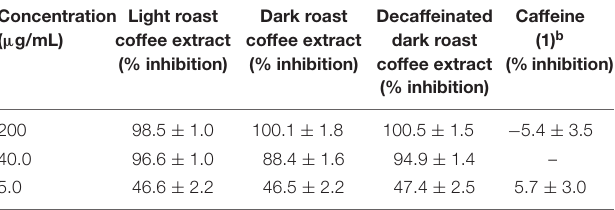
TABLE 1 | Inhibition of A β fibril formation by coffee extracts in ThT fluorescence assay. a Concentration ( µ g/mL)